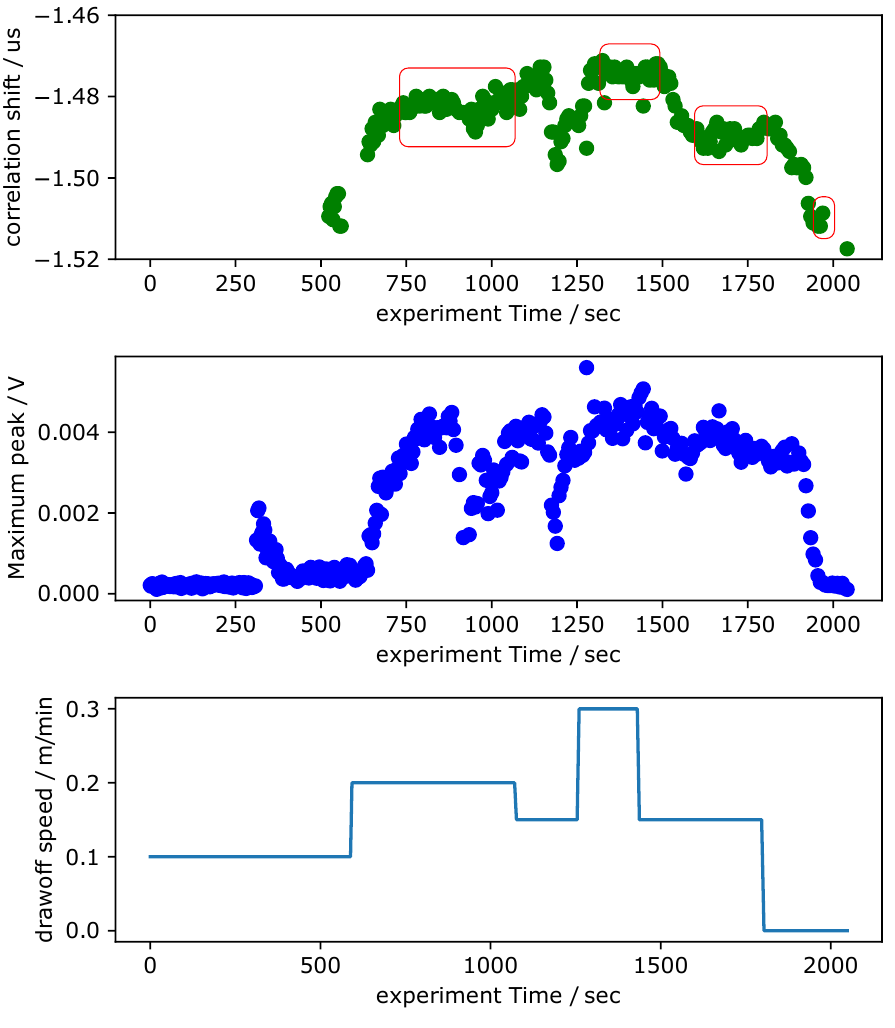
Figure 9. Correlation shift, received signal strength, and pull speed of the ultrasonic cure monitoring during the pultrusion